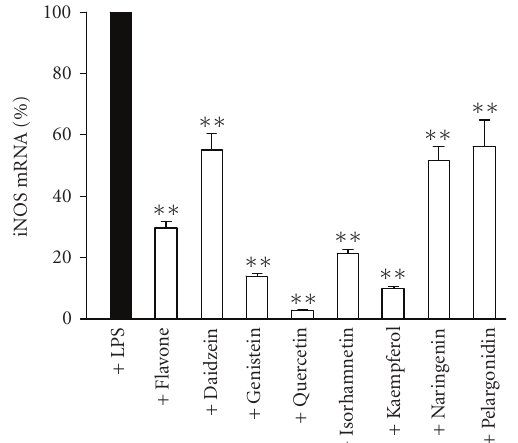
Figure 4: E ff ects of flavonoids on iNOS mRNA expression. Cells were treated with LPS (100 ng/ml) or with LPS and the tested com- pound (100 μ M) and RNA was extracted after 6 hours. iNOS and GAPDH mRNA were measured by real-time RT-PCR and iNOS mRNA levels were normalised against GAPDH. Mean + SEM, n = 3, ∗∗ P < . 01.